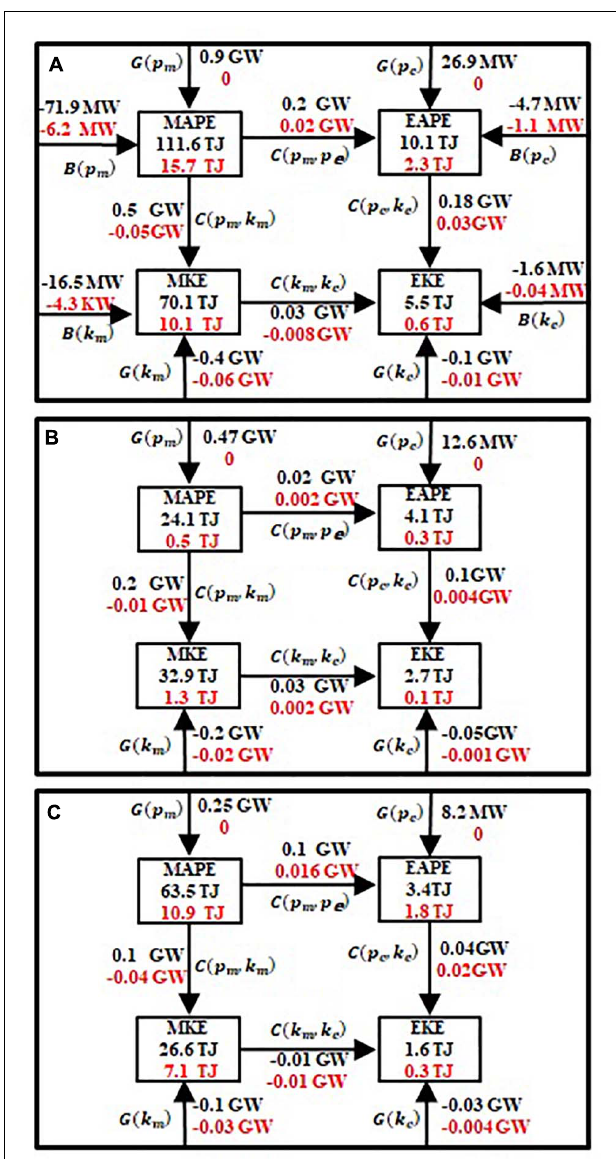
FIGURE 11 | Schematics of energy budgets in the CONTROL (black) and the Exp-shutdown (red) experiments over the whole AIS cavity (A) , region AIS1 (B) and region AIS2 (C) . The B terms in (A) represent the energy flows through the northern boundary at the AIS calving